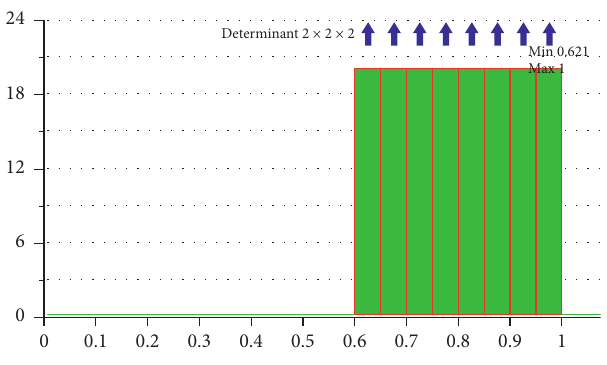
Figure 5: Determinant 2 × 2 × 2 mesh quality map.